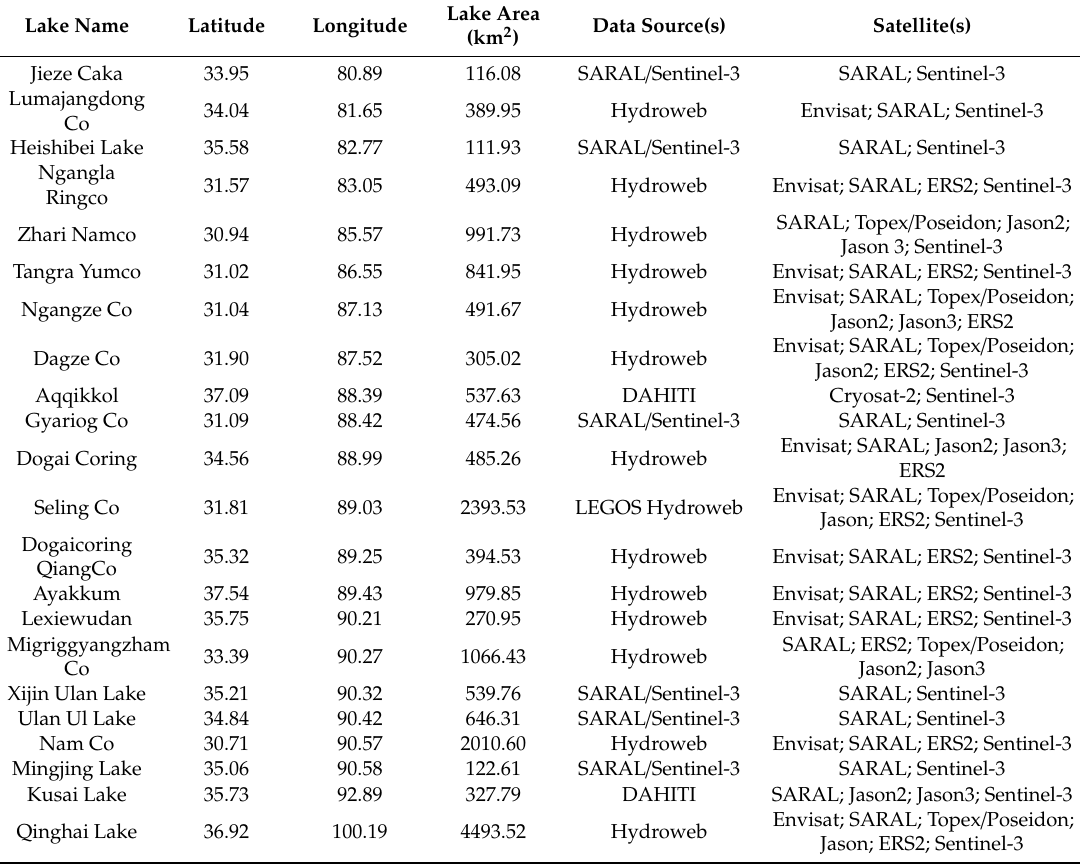
Table 2. Our studied lakes in the Tibetan Plateau (TP) measured by satellite